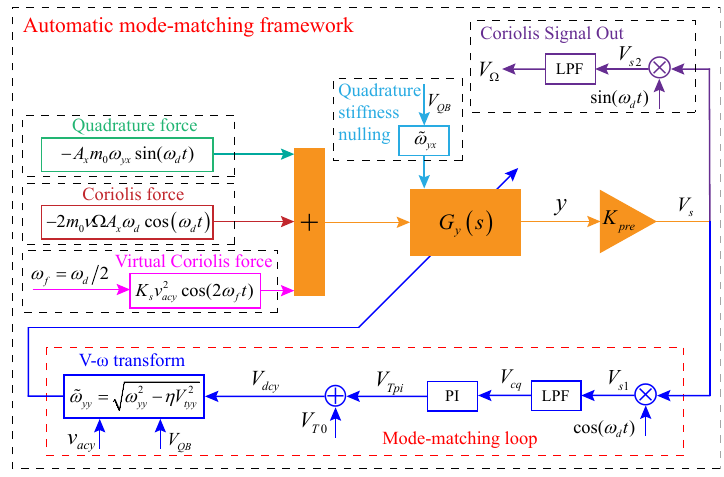
Figure 5. The automatic mode-matching control scheme